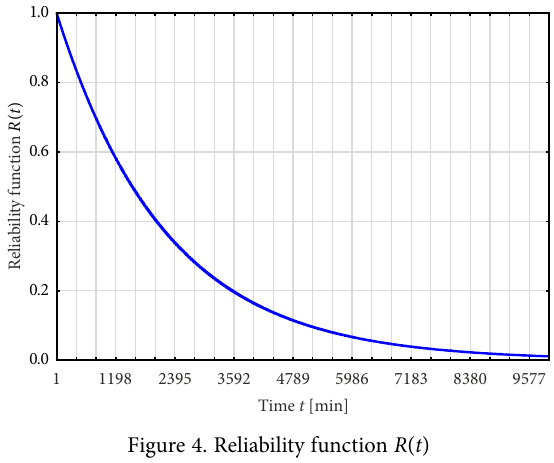
Figure 4. Reliability function R ( t